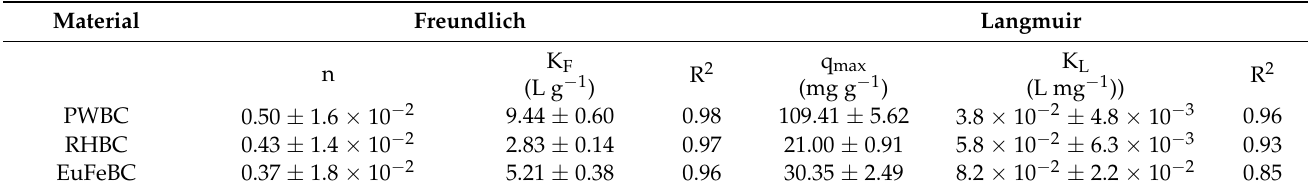
Table 3. Optimized parameters of Freundlich and Langmuir models.